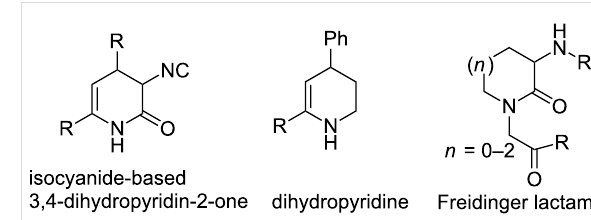
Figure 3: Isocyanide substituted 3,4-dihydropyridin-2-ones, dihydropy- ridines and the Freidinger lactams. Bio-active calcium channel modula- tors, the dihydropyridines should contain an axial phenyl substituent at the C4-center adopting a boat conformation.